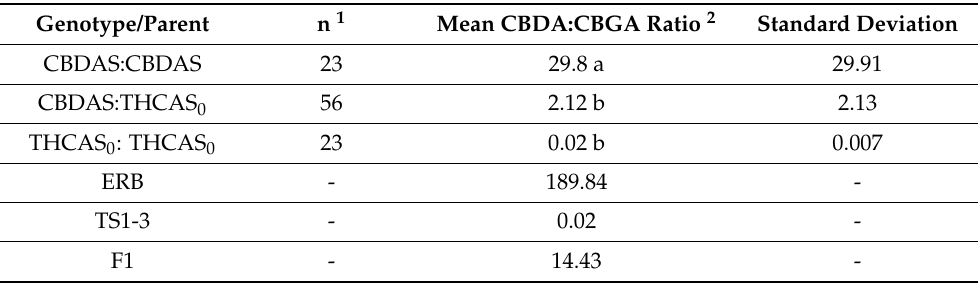
Figure 1. Distribution of CBDA:CBGA ratios in Cross TE, a backcrossed F 2 population of 102 in- dividuals resulting from an F 1 cross between a Type III (CBDA-dominant) plant and a Type IV (CBGA-dominant) C. sativa plant. The arithmetic mean is indicated with a diamond. Whiskers indi- cate 1.5 × the inner quartile range and open circles are observations that fall outside of this parameter. Table 3. Mean CBDA:CBGA ratios among three genotypes tested in Cross TE and the CBDA:CBGA ratios of parents and F1